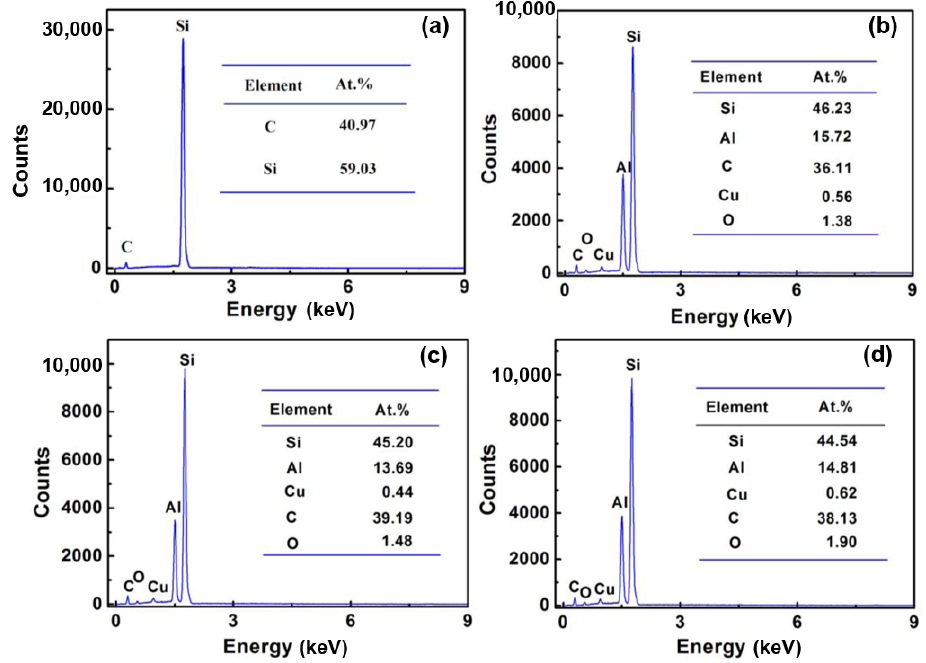
Figure 3. EDS analysis of SiC ceramic inner areas infiltrated at 800 °C for different time: ( a ) SiC ceramic, ( b ) 30 min, ( c ) 2 h, and ( d ) 6 h.